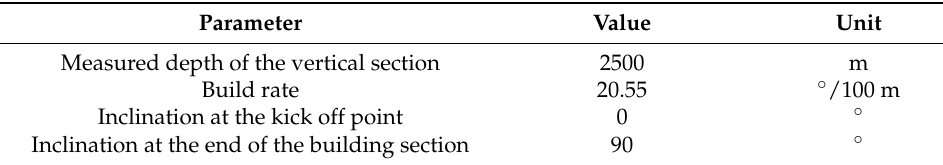
Table 1. Trajectory design of the horizontal